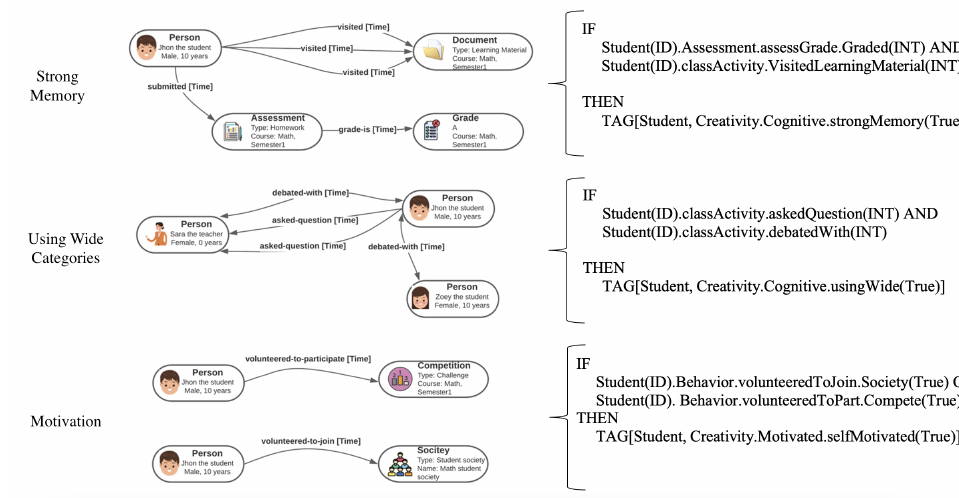
Figure 5. Three examples of the creativity rules and their related patterns: Strong Memory, Using Wide Categories, and Motivation.